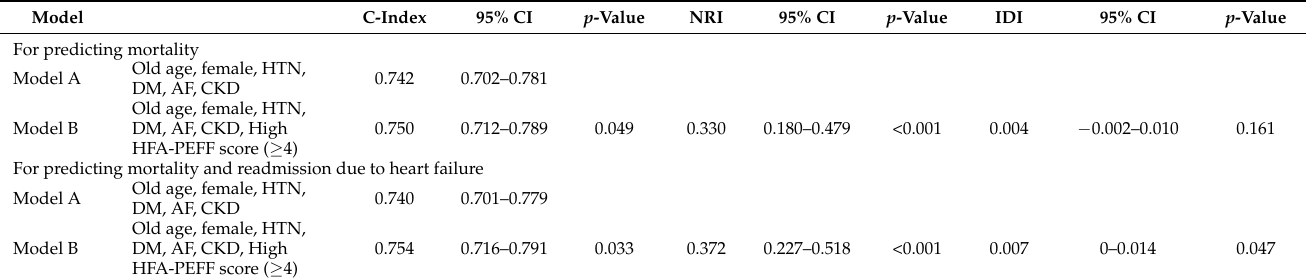
Table 5. Effects of variables on the prediction accuracy and risk reclassification of each model (conventional risk factors only vs. conventional clinical risk factors + high HFA-PEFF score